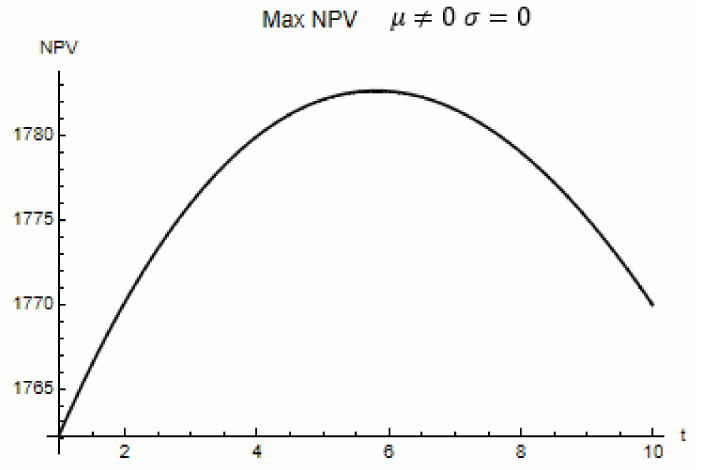
Figure 6. Likewise, even without uncertainty, it may be desirable to wait for the optimal delay period (in our case, about 6 years).